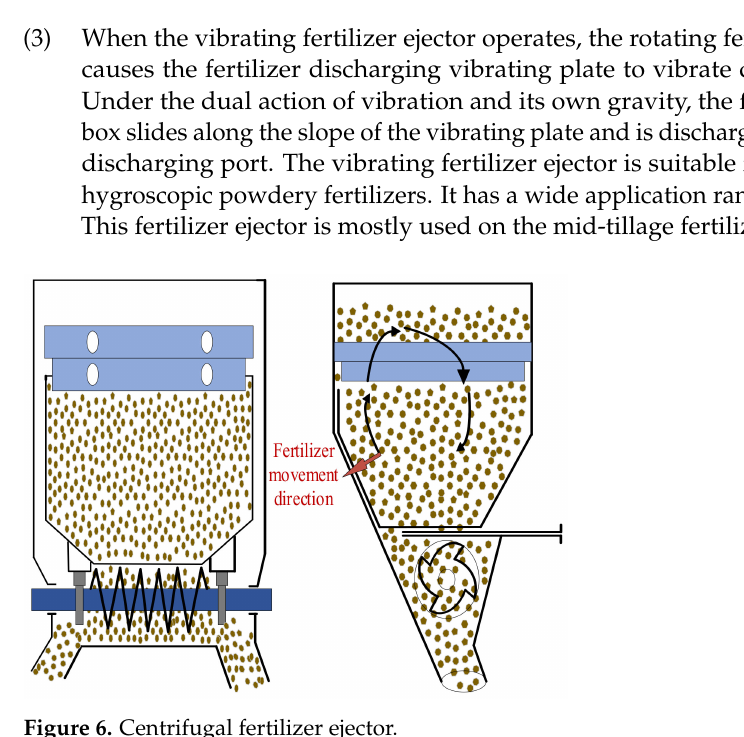
Figure 6. Centrifugal fertilizer ejector. (4) The star wheel-type fertilizer extractor is used to apply crystalline and dry powder fertilizers (Figure 7). During the fertilization operation, the rotating star wheel contin- uously directs fertilizer from the fertilizer tank into the fertilizer pipe. The adjustment of the discharge quantity of the star wheel-type fertilizer exhauster can be realized by adjusting the opening of the discharge valve or changing the speed of the star wheel. Under normal circumstances, the bottom of the fertilizer tank is movable to facilitate the cleaning of excess fertilizer. The star wheel fertilizer exhauster is easy to disassemble and has low troubleshooting difficulty